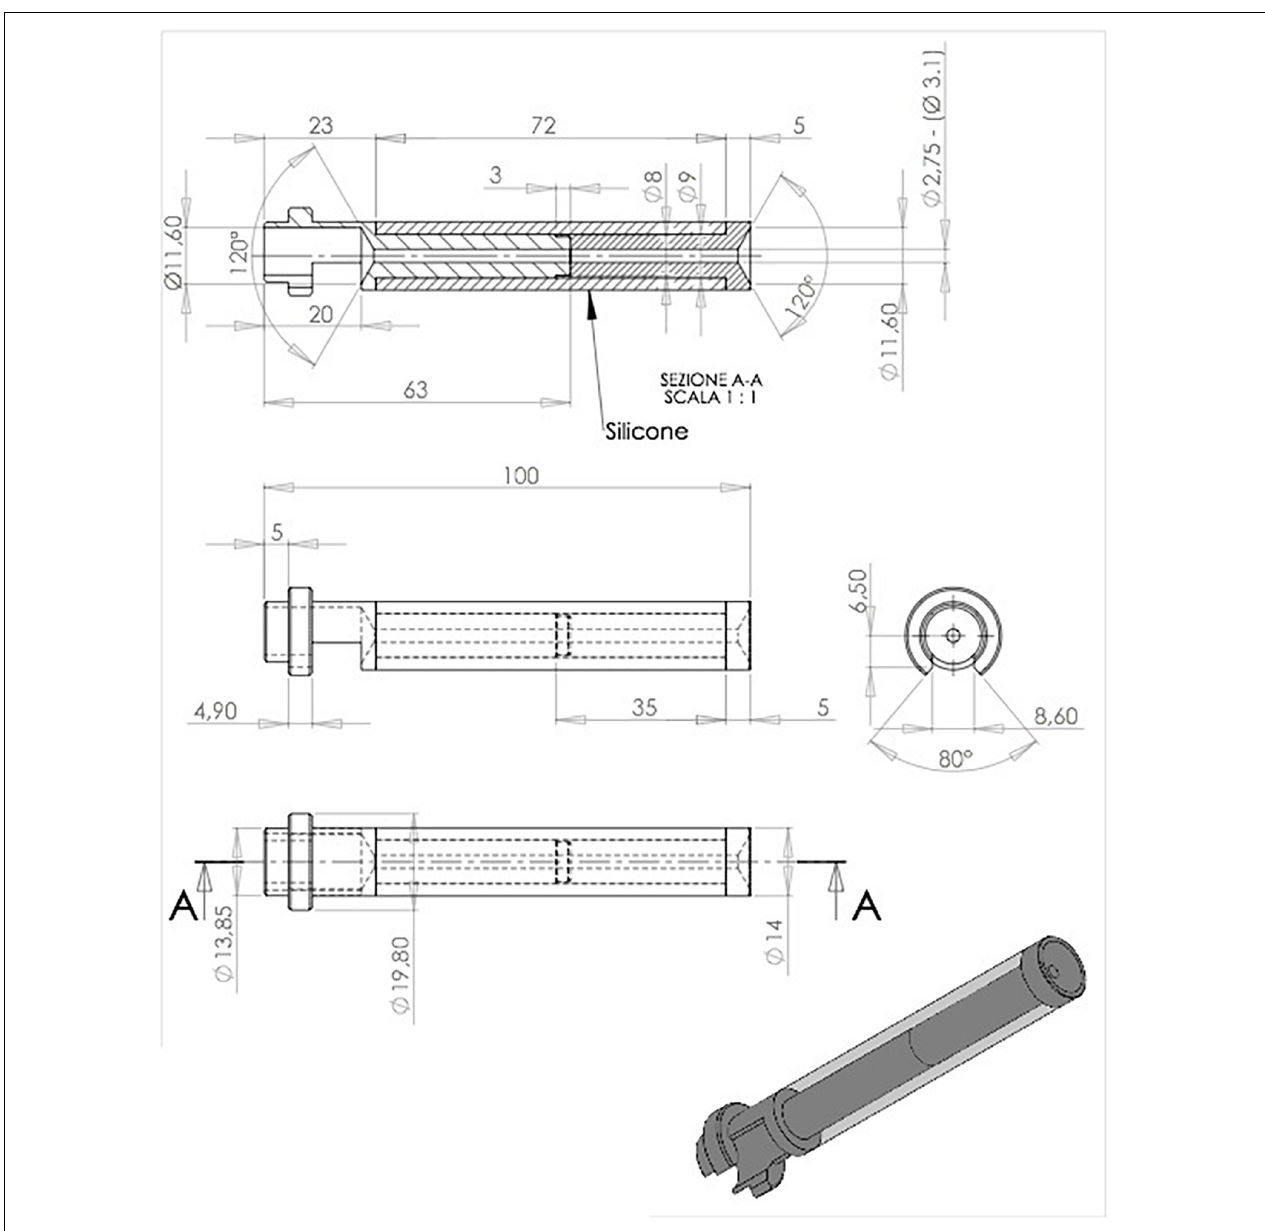
FIGURE 2 | External ventricular drain (EVD) device, detailed